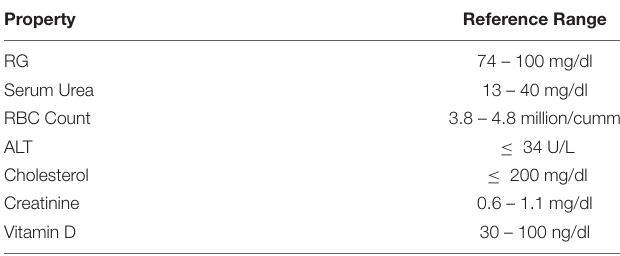
TABLE 1 | Reference ranges of the analysed